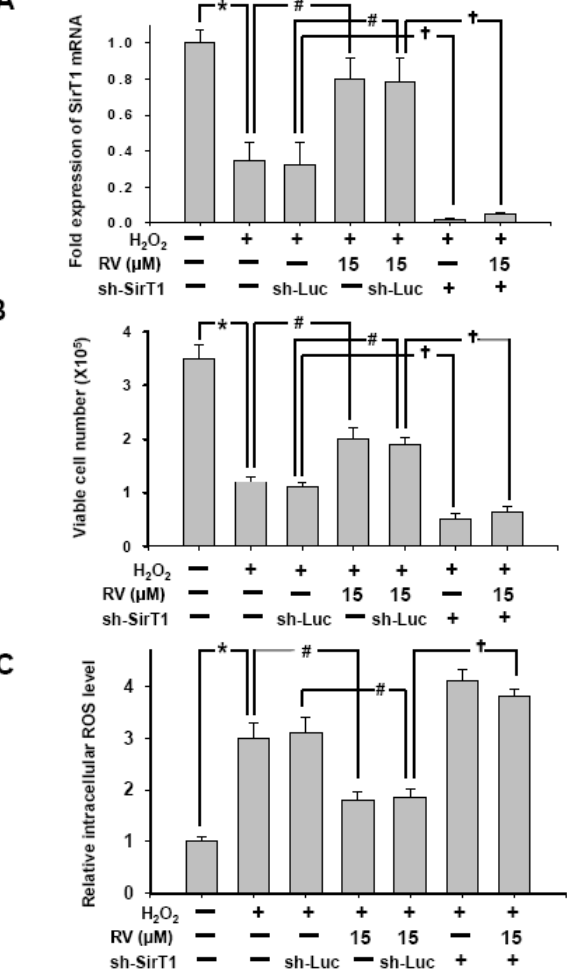
Figure 6. Resveratrol Protects Against H O -induced damage in RSCs via the Activation 2 2 of SirT1. (A) Total RNA was extracted, and SirT1 mRNA levels were examined by Q-PCR. After 2 days of treatment with 15µM of RV, rat RSC were treated with 100  mol  L –1 H O or vehicle for 8 h, followed by detection of SirT1 mRNA level 2 2 (A, fold of control) (B) Cell viability for 48 hours were shown in RSCs treated with 0, 15 μM of RV after knock down by sh-Luc or sh-SirT1 (C) Reactive oxygen species (ROS) production was detected (C, fold of control). *p < 0.05. #p < 0.05.  p < 0.05. Data shown here are the mean  SD of three